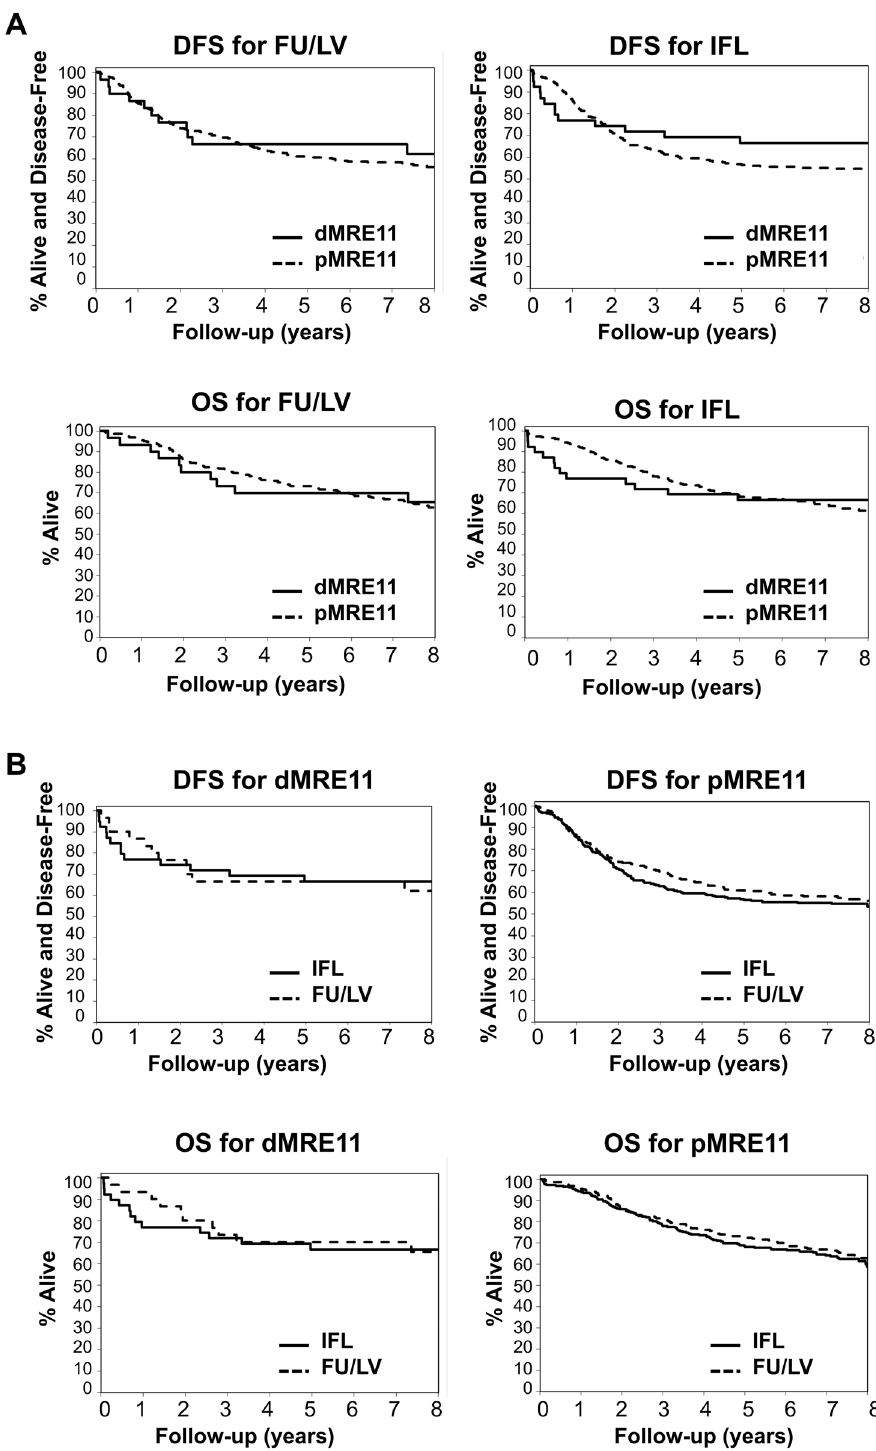
Figure 4. Assessment of tumor MRE11 status as predictive of benefit from FU/LV and IFL. (A) Top: Disease free survival for dMRE11 vs. pMRE11 treated with FU/LV [n=320; dMRE11 n=31; events=11; 5-yr rate: 67% (95% CI: 52–86%); pMRE11 n=289; events=122; 5-yr rate: 61% (95% CI: 56–67%)] or with IFL [n=305; dMRE11 n=39; events=13; 5-yr rate: 67% (95% CI: 53–83%); pMRE11 n=266; events=118; 5-yr rate: 57% (95% CI: 51–63%)]. Bottom: Overall survival for dMRE11 vs. pMRE11, treated with FU/LV [n=320; dMRE11 n=31; events=10; 5-yr rate: 70% (95% CI: 55–89%); pMRE11 n=289; events=98); 5-yr rate: 73% (95% CI: 68–79%)] or with IFL [n=305; dMRE11 n=39; events=13; 5-yr rate: 67% (95% CI: 53–83%); pMRE11 n=266; events=96; 5-yr rate: 69% (95% CI: 63–75%)]. (B) Top: Disease-free survival for IFL vs. FU/LV treated dMRE11 [n=70; IFL N=39; events=13; 5-yr rate: 67% (95% CI: 53–83%); FU/LV n=31; events=11; 5-yr rate: 67% (95% CI: 52–86%)] or pMRE11 (n=555; IFL n=266; events=118; 5-yr rate: 57% (95% CI: 51–63%; FU/LV n=289; events=122; 5-yr rate: 61% (95% CI: 56–67%)]. Bottom: Overall survival for IFL vs. FU/LV-treated